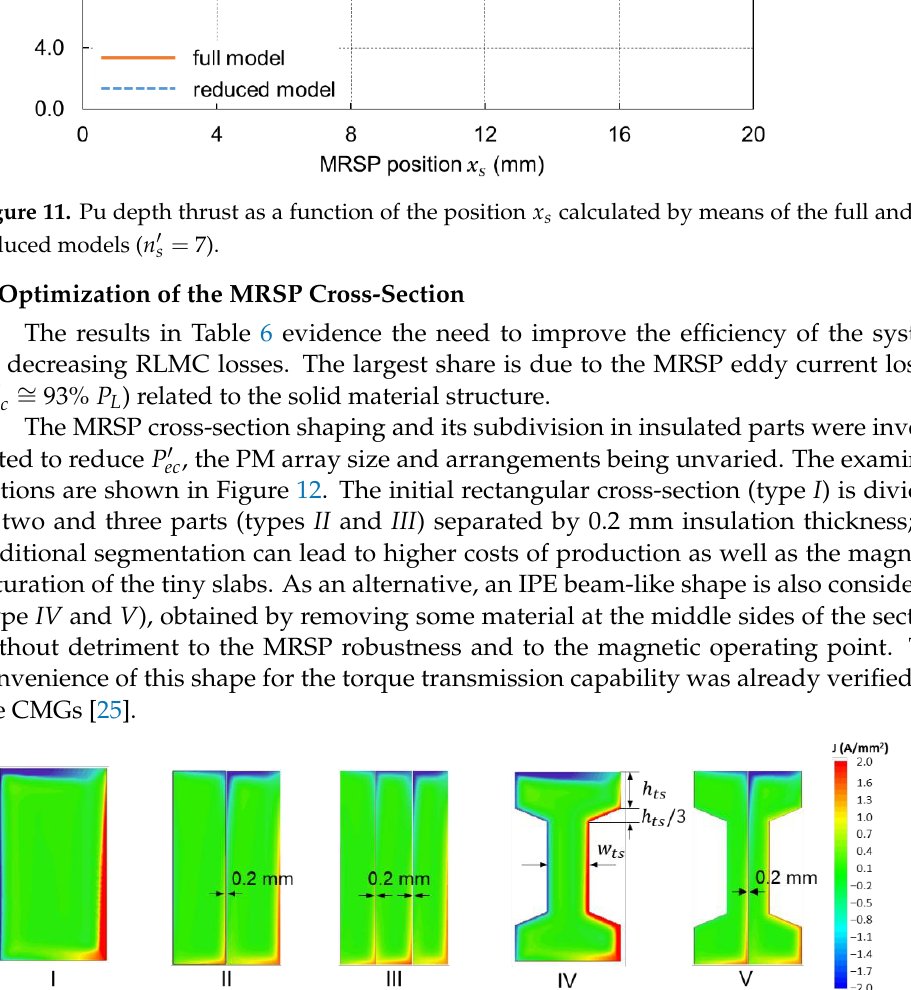
Figure 11. Pu depth thrust as a function of the position 𝑥 𝑠 calculated by means of the full and the reduced models ( 𝑛 𝑠′ = 7).